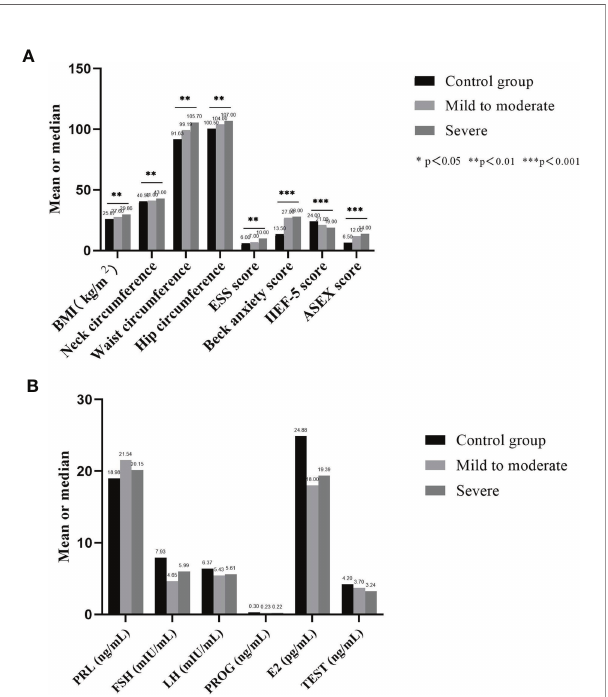
FIGURE 2 | Comparison of basic data and hormone secretion levels of each group. (A) shows that among the non-OSA subjects, patients with mild to moderate OSA, and patients with severe OSA, the BMI, neck circumference, waist circumference, hip circumference, ESS score, Beck anxiety score and ASEX score showed a signi fi cant increase, while the IIEF-5 score signi fi cantly decreased; (B) shows that no signi fi cant difference was found in the secretion levels of the six serum sex hormones among the three